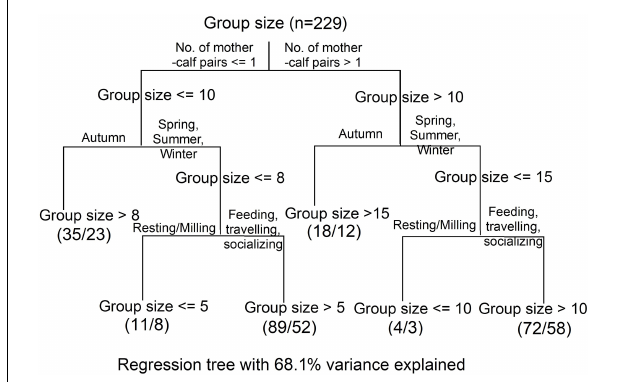
FIGURE 6 | A classification and regression tree (CART) to explain group size variability of Indo-Pacific humpback dolphins in the eastern waters of Zhanjiang, China. Explanatory variables included number of mother-calf pairs (0, 1, 2, and 3), season (spring, summer, autumn, and winter) and behavioral state (feeding, traveling, socializing, and resting/milling). Each split was labeled with a threshold of group size that determined the split. For each of six final leaves, successfully observed values and failure ones were shown, respectively. Each terminal node was labeled with a final threshold of group